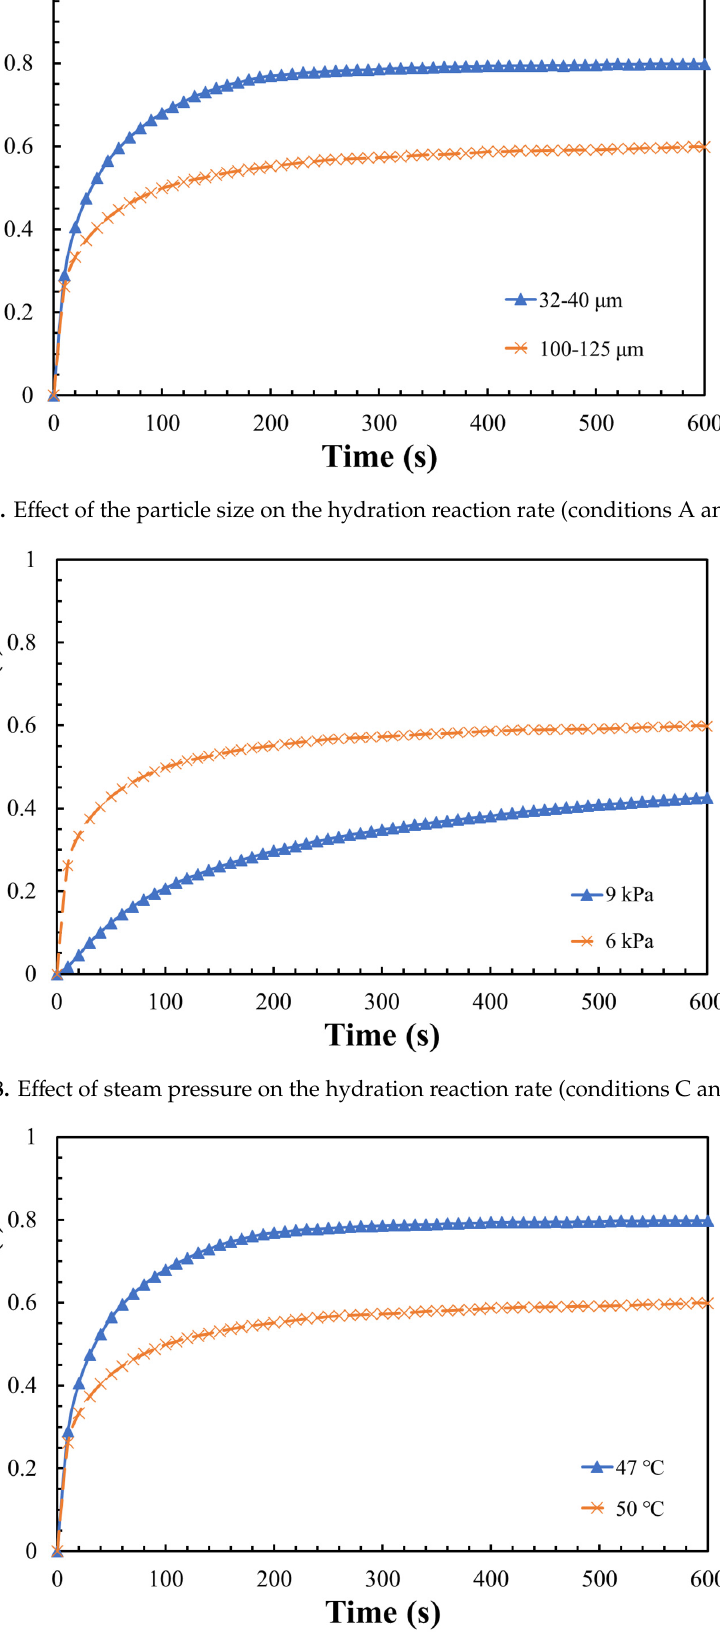
Figure 9. E ff ect of temperature on the hydration reaction rate (conditions A and B).